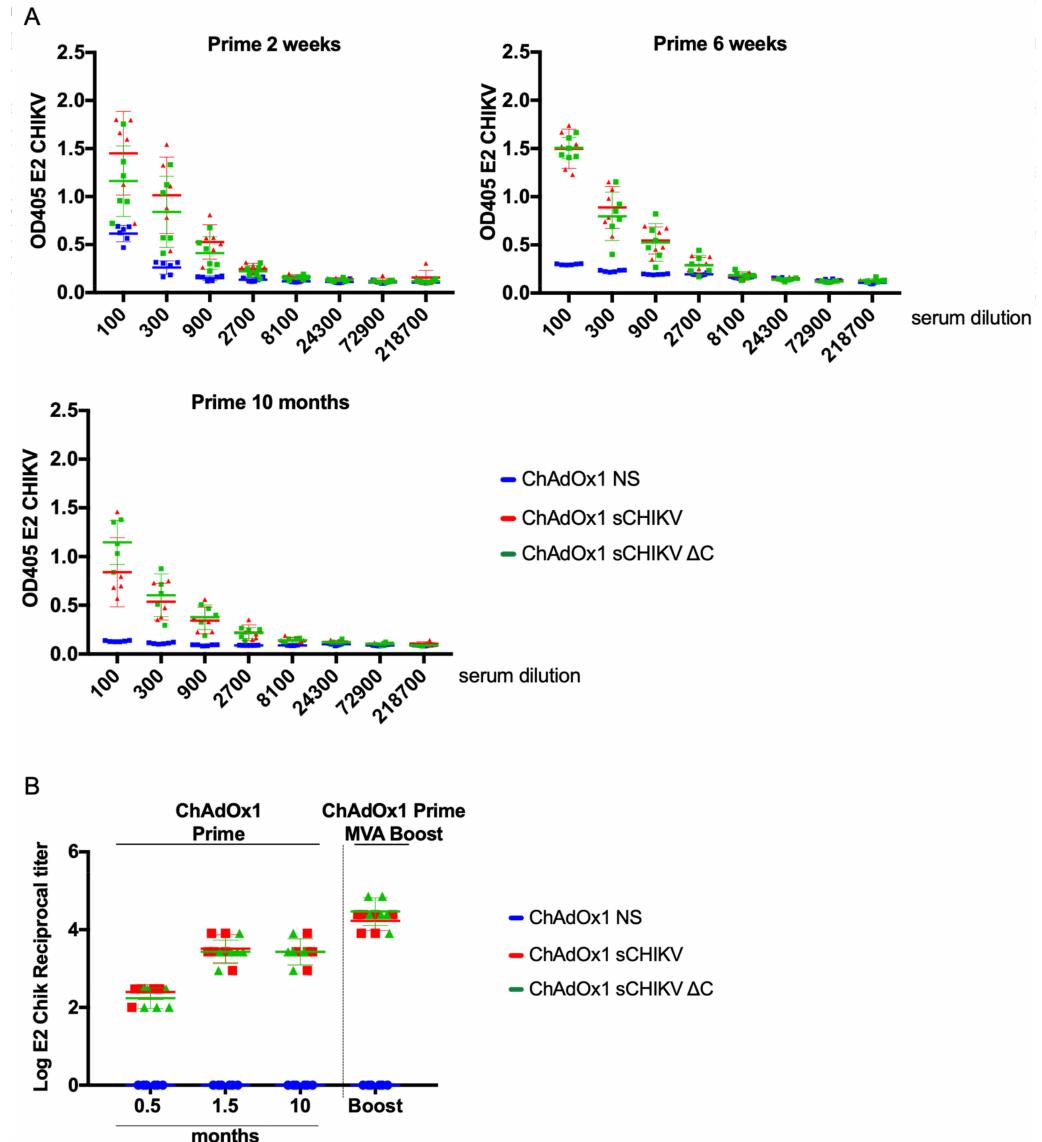
Figure 5. Humoral immune responses elicited by viral-vectored vaccines. ( A ) BALB/c mice ( n = 6 per group) were immunised intramuscularly (i.m.) with a dose of 10 8 I.U. of ChAdOx1 vaccines. CHIKV E2 ELISA was performed with sera obtained from vaccinated mice at week 2, week 6 and 10 months after a single ChAdOx1 vaccination in which the OD405 values are represented over several 3-fold sera dilutions. ( B ) Reciprocal log E2 ELISA titters were calculated for all groups shown in A. In addition, a heterologous prime 1.5 month-boost 0.5 month is presented. Colours and shapes represent groups vaccinated with each